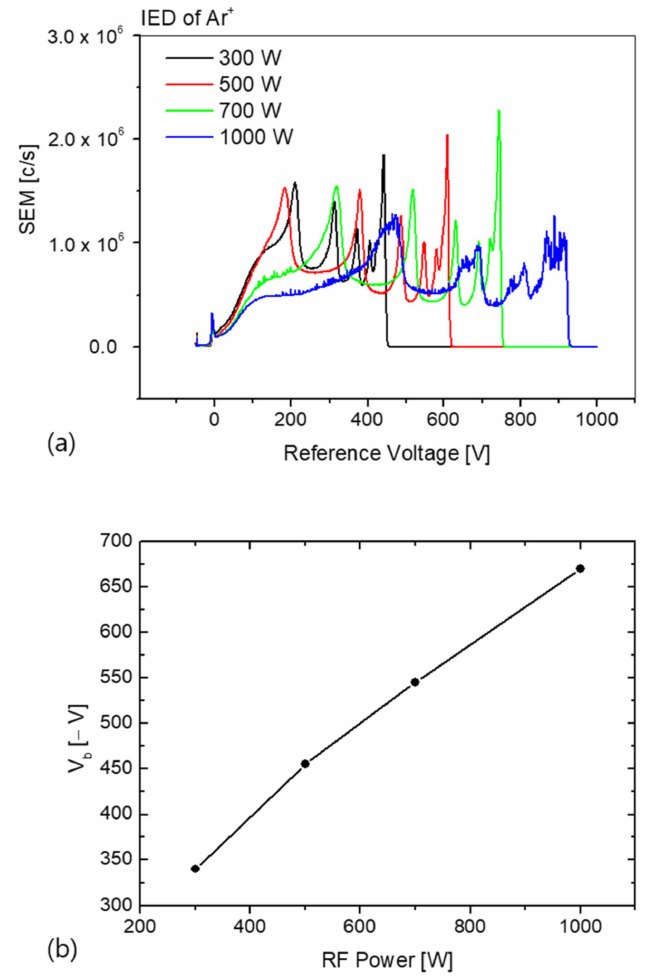
Figure 2. ( a ) IEDs of Ar + ions at the RF-powered electrode as a function of the RF power, ( b ) Self-bias voltage ( V b ) as a function of the RF power, at a fixed pressure of 20